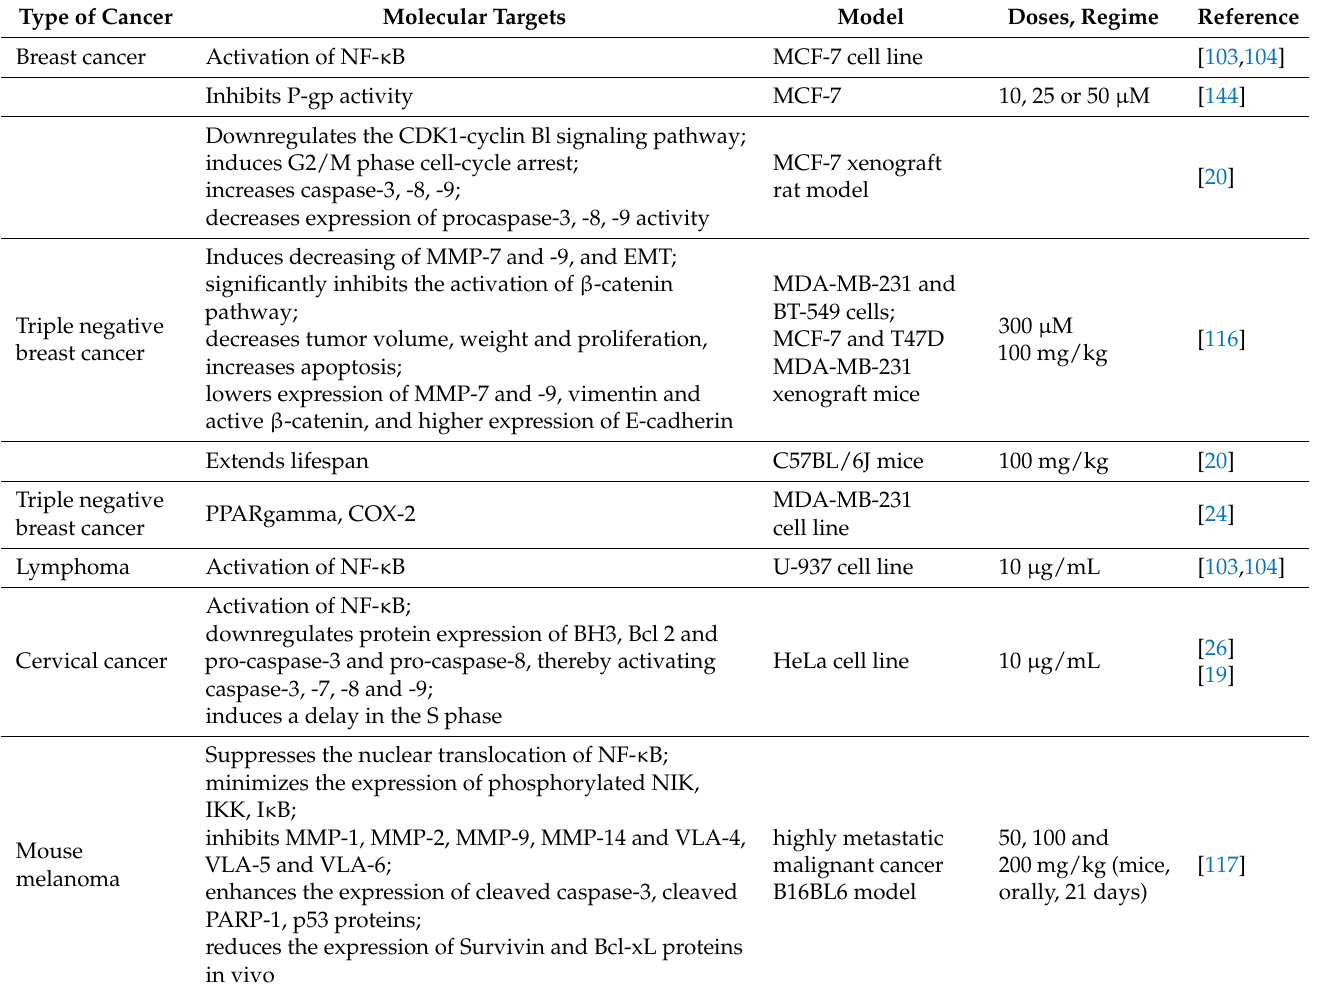
Table 1. Summary of mangiferin targets in different types of